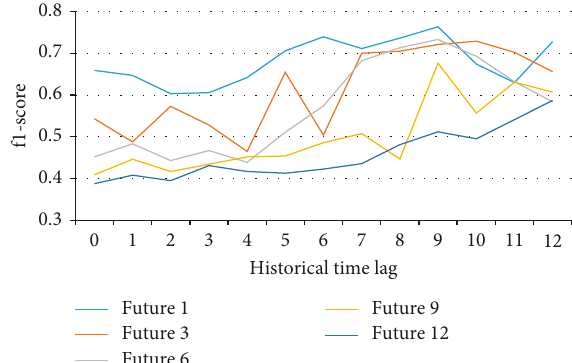
Figure 6: Influences of different historical time lag over different future time lag.